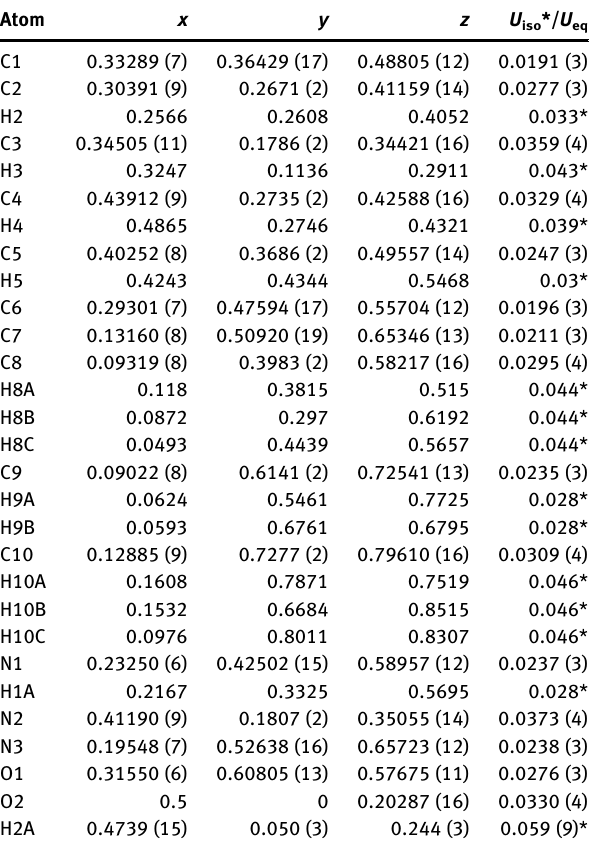
isotropic displacement parameters (Å 